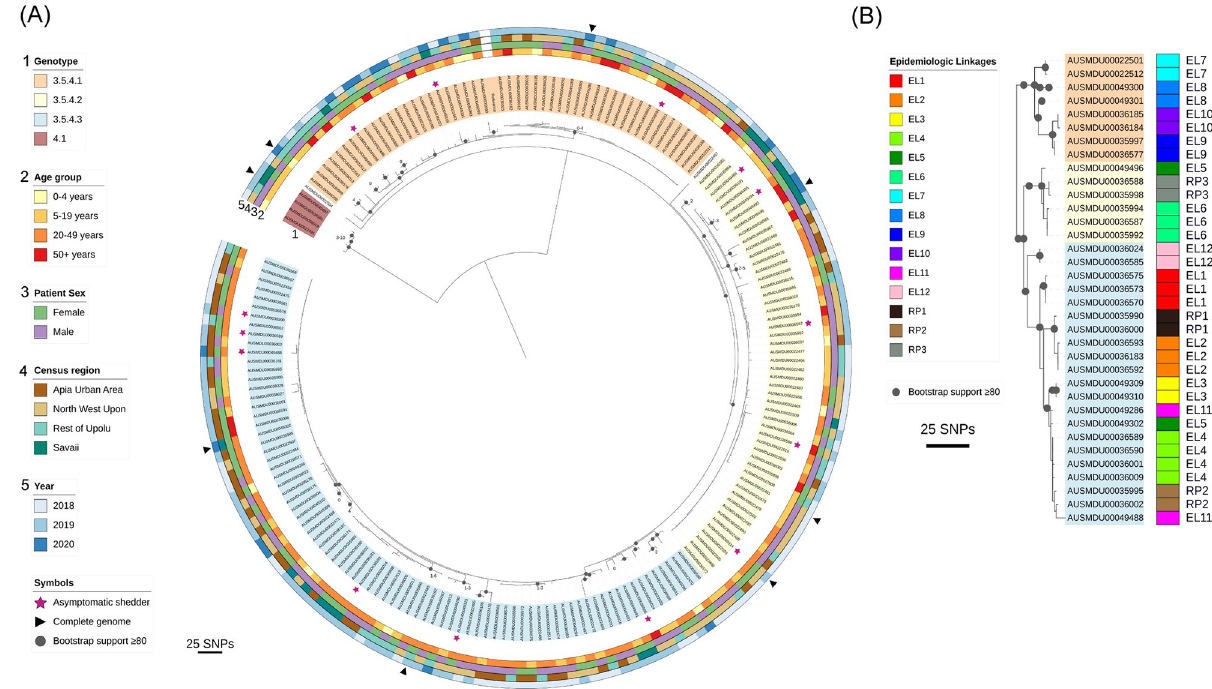
Fig 3. Maximum-likelihood phylogeny, associated epidemiologic variables, and epidemiologic linkages among S . Typhi from Samoa from April 2018 through June 2020. (A) Maximum-likelihood phylogeny from de novo assembled whole genome sequences of Samoan S . Typhi genotype 3.5.4 isolates from April 27, 2018 through June 9, 2020 (N = 186, S1 Table). Core genome single nucleotide polymorphisms (SNPs) were identified relative to the 2012 Samoa Reference genome H12ESR00394-001A (GCA_001118185.2). Genotype/sub-lineage is indicated by isolate label shading (ring 1). Two outlier isolates are not shaded. Asymptomatic shedders of S . Typhi are denoted with a pink star. The patient age group (ring 2), patient sex (ring 3), census region of residence (ring 4), and year of isolation (ring 5) are annotated in the circumscribing colored rings. (B) Epidemiologic linkages (EL) identified through case household investigations are compared against genomic relatedness of the isolates based on core genome phylogeny. The visible isolates were extracted from the tree in Panel A. In total 2/12 epidemiologic linkages are not supported by the genomic variation observed in the isolates from those samples (EL5/dark green and EL11/pink groups are not similar). Three repeat positive (RP) blood cultures isolated ~1 month apart are also compared, showing close genetic similarity.